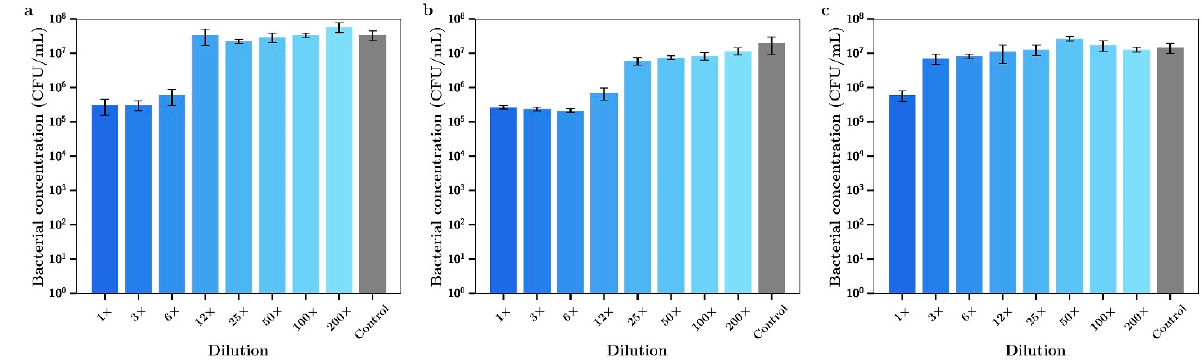
Figure 15. Bacterial concentrations of S. aureus incubated in various dilutions of 7-day incubation release media from bone cement loaded with ( a ) Ag, ( b ) Ag + vancomycin, ( c ) vancomycin. (Silver loaded at 0.8% and vancomycin at 0.8% w/w ) ( n = 3).